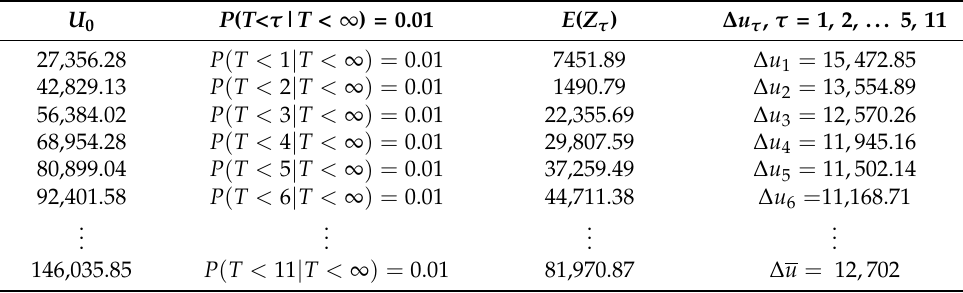
Table 4. Additional capital ∆ u τ for P ( T < τ | T < ∞ ) = 0.01.